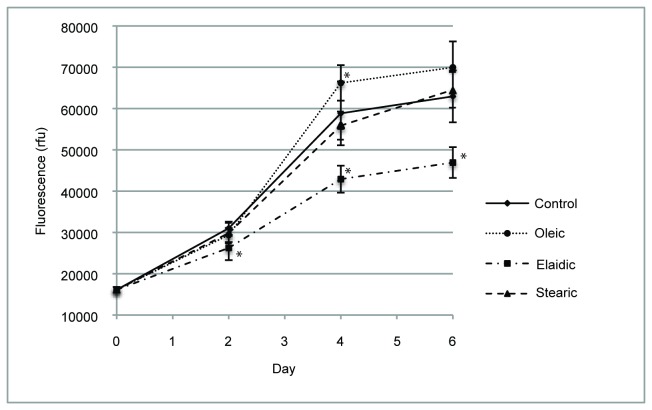
HepG2-SF cell proliferation during FA incubation.Proliferation of HepG2-SF cells in supplemented medium (100 µM FFA) was followed during six days of incubation and measured on day 0, 2, 4 and 6 by CyQuant cell proliferation assay, where fluorescence (y-axis) is a measure of cell numbers. HepG2-SF cell proliferation is differentially affected by EA, OA and SA. EA supplemented cells appear to be compromised on their growth rate when compared to Control, OA and SA supplemented cells. * marks measurements significantly differing from controls using the unpaired t-test, two-tailed with a 95% confidence interval.